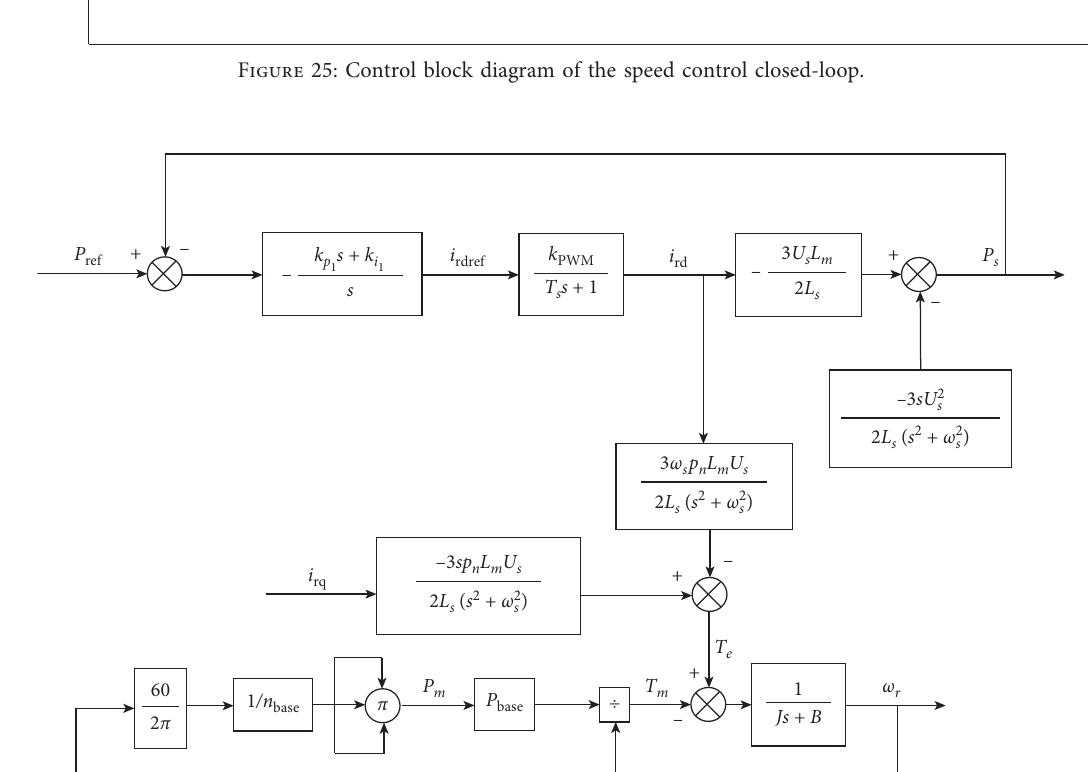
Figure 25: Control block diagram of the speed control closed-loop.